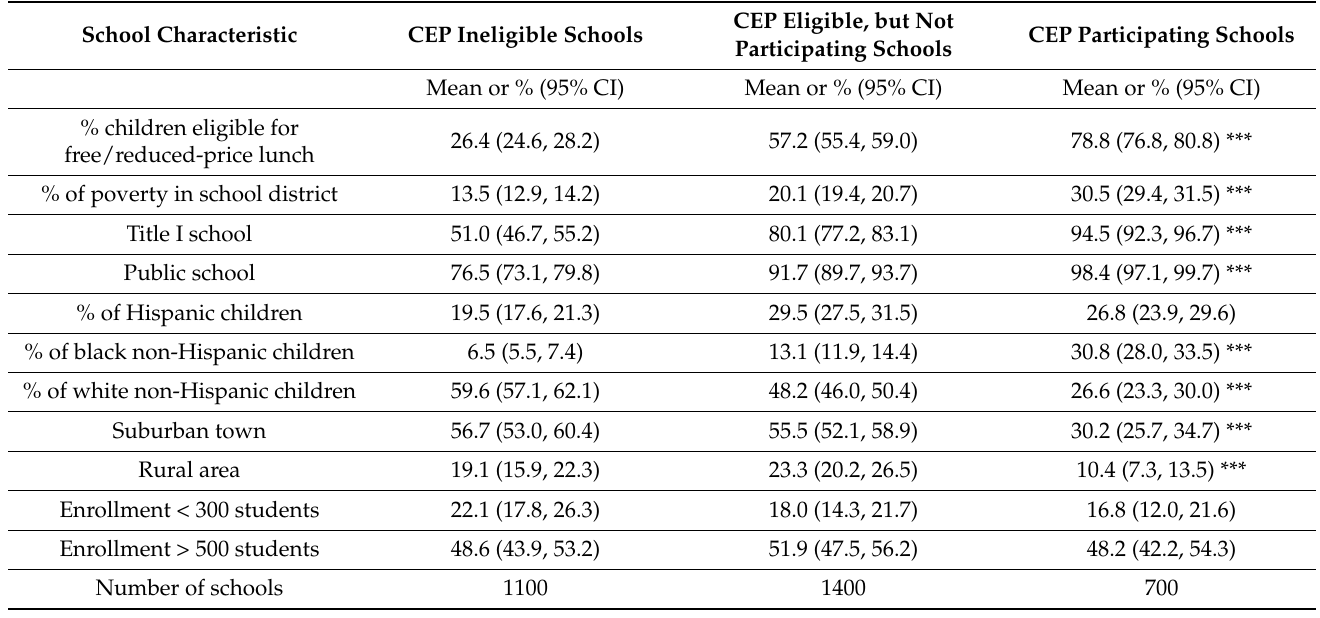
Table 1. Survey-adjusted School Characteristics by CEP Participation and Eligibility Status in the Analytic Sample from the Early Childhood Longitudinal Study, Kindergarten Class of 2010–2011